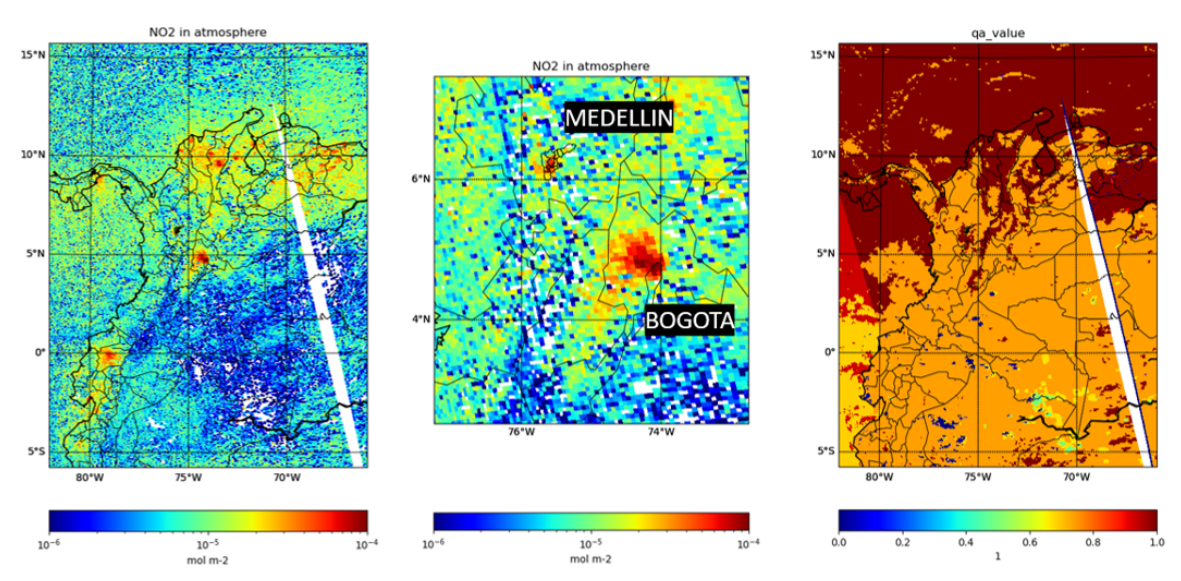
Figure 3. TROPOMI NO 2 column measurements. ( Right ) TROPOMI Offline level 2 data for the overpass over Colombia on 2 April 2019. ( Center ) As before, zoomed over Bogotá and Medellí, the two largest (population-wise) Colombian cities. ( Right ) Quality flag values for the corresponding data.